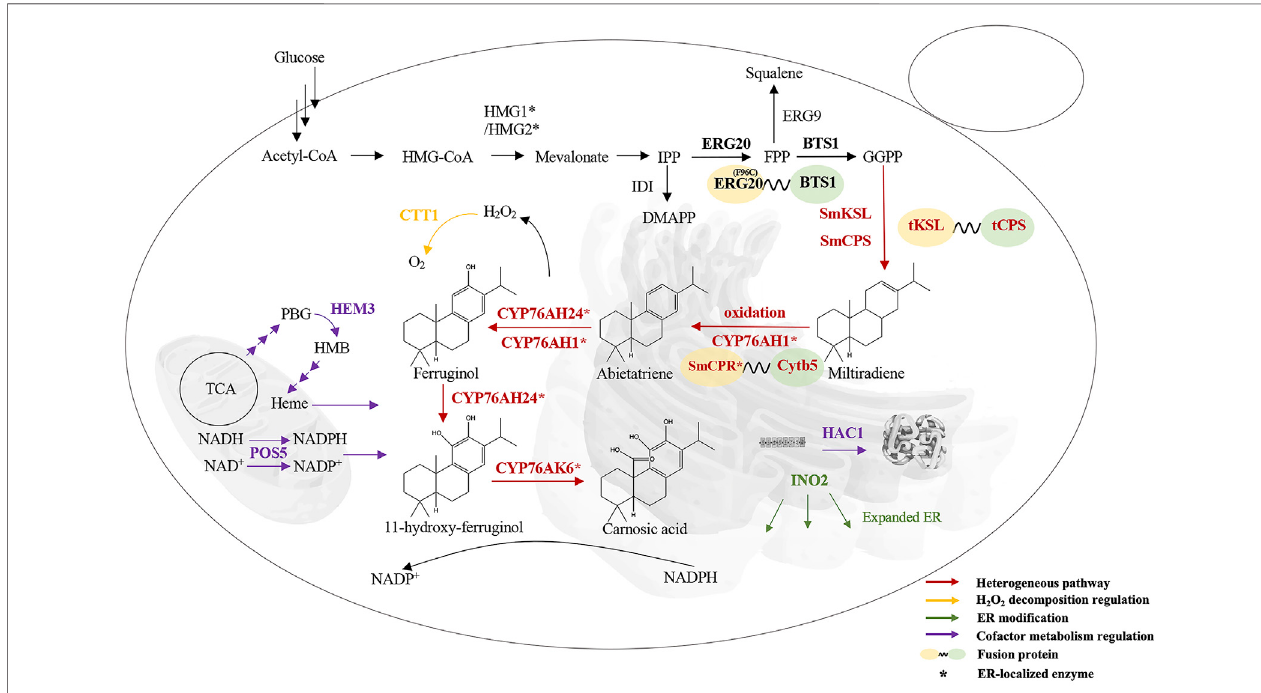
FIGURE 1 | Overall strategy of CA production in S. cerevisiae . HMG1/HMG2, HMG-CoA reductase; IDI, isopentenyl pyrophosphate isomerase; ERG20, FPP synthase; ERG9, squalene synthetase; BTS1, GGPP synthase; SmCPS/SmKSL, miltiradiene synthase; CYP76AH24, 11-hydroxy-ferruginol synthase; CYP76AK6, CA synthase;CYP76AH1, ferruginol synthase;HMG-CoA, hydroxymethylglutaryl-CoA; SmCPR,cytochromeP450reductase; Cytb5, cytochrome B5; CTT1,catalase; ER, endoplasmic reticulum; INO2, transcription factor that promotes phospholipid synthesis; HAC1, transcription factor that promotes protein folding; HEM3, heme synthase; TCA, tricarboxylic acid cycle; POS5, NADH kinase. Three arrows represent multistep reactions.